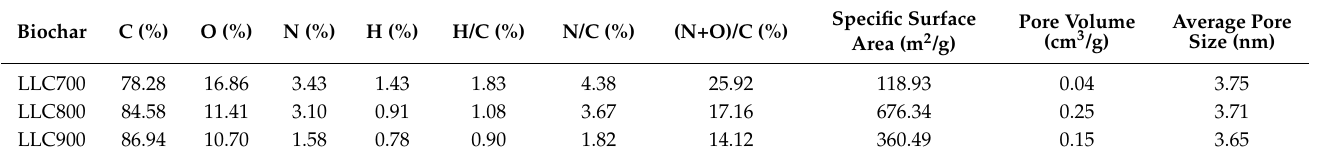
Table 1. Elemental content and pore characteristics of lotus leaf-based biochar at different pyrolysis temperatures.